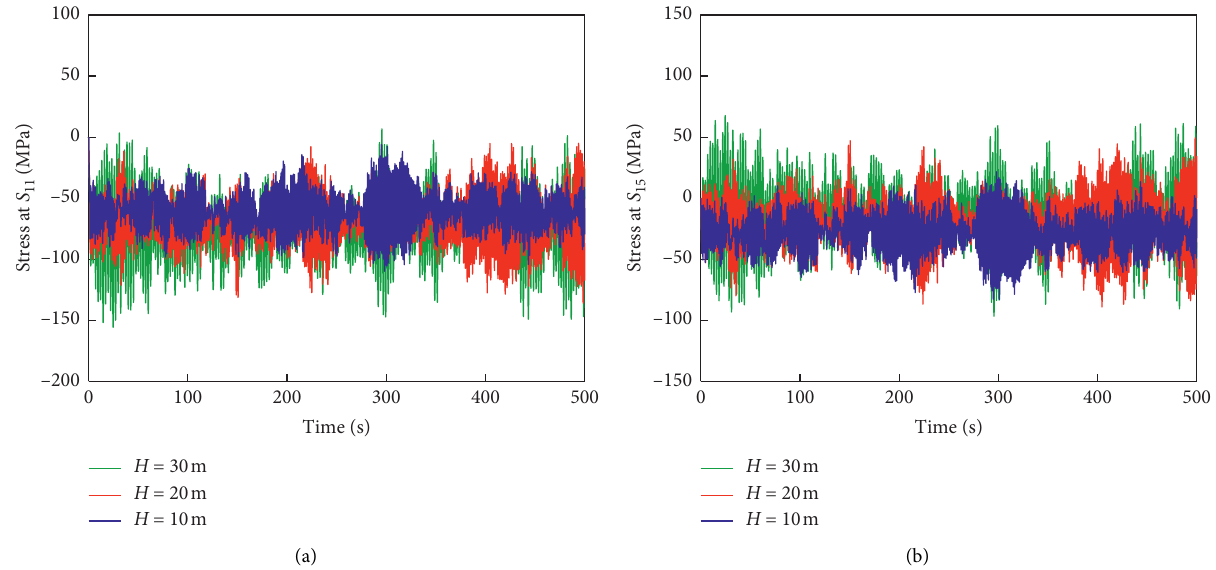
Figure 14: Comparison of stress at the pile top cross section with different water depth: (a) time histories of stress at S stress at S 15 ( v � 36cm/s, h � 8cm, σ � 1.0 MPa).